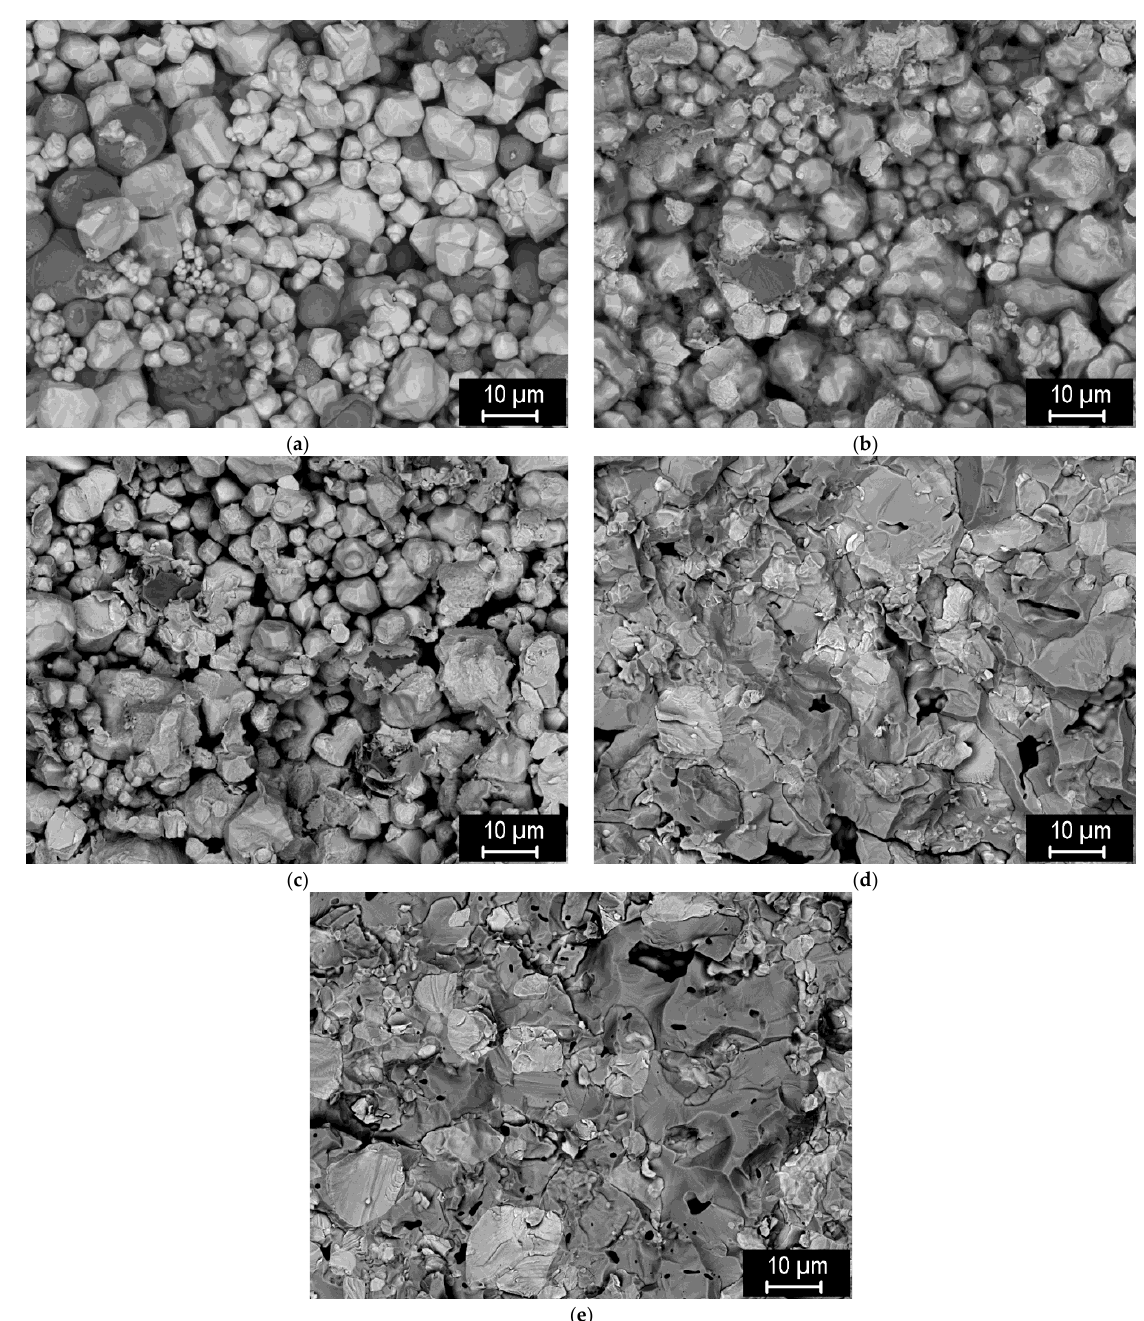
Figure 12. Fracture surfaces of 75% W—25% steel composites sintered at various